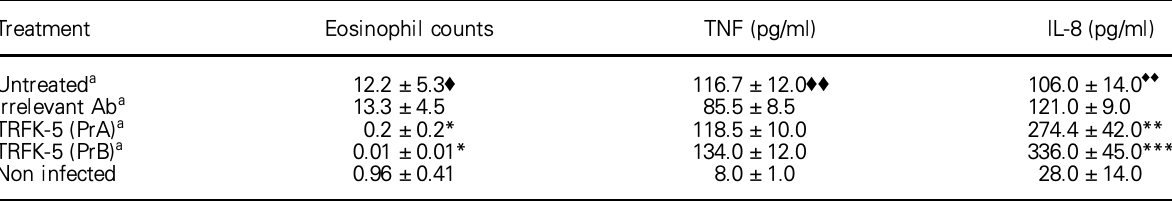
Table 1. Blood eosinophil counts and serum TNF and IL-8 levels in T. canis infected guinea-pig untreated or treated with TRFK-5 Treatment